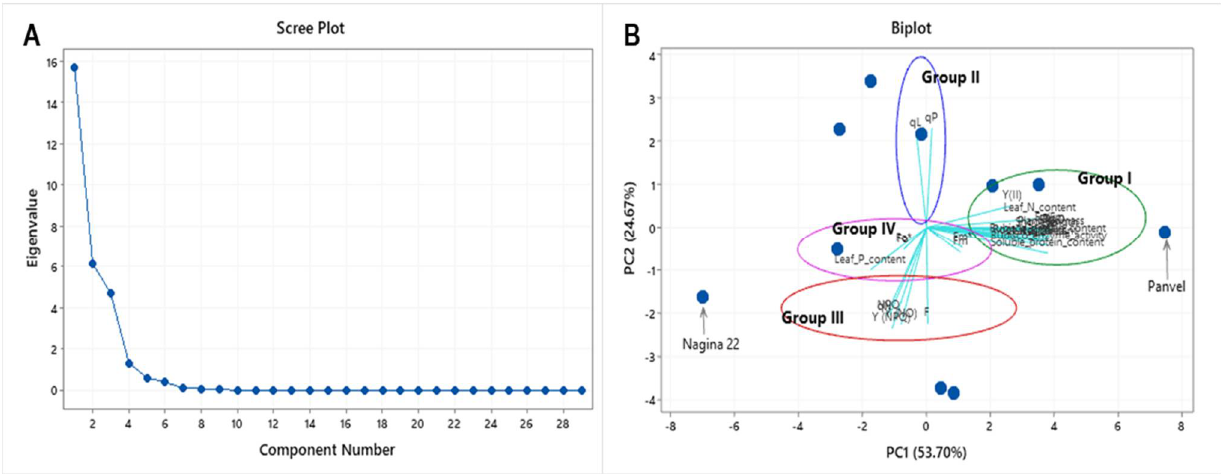
Figure 1. Principle component analysis of 29 response variables of ten rice cultivars under low–NPS supply. ( a ) Scree plot represents the Eigenvalue of 29 traits, and ( b ) biplot represents variance between cultivars and traits. Traits were classified into four groups (group–I, II, III, and IV), and a pair of contrasting cultivars was denoted (Nagina 22 and Panvel).